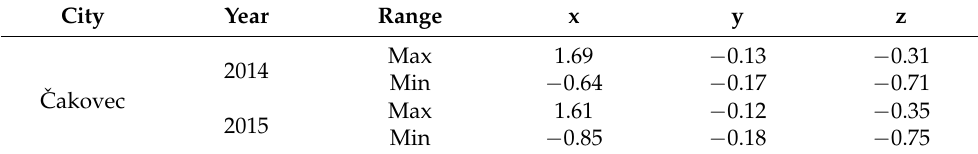
Table 3. Values of RTE corrections by the proposed model for ˇCakovec GNSS location (in m). City